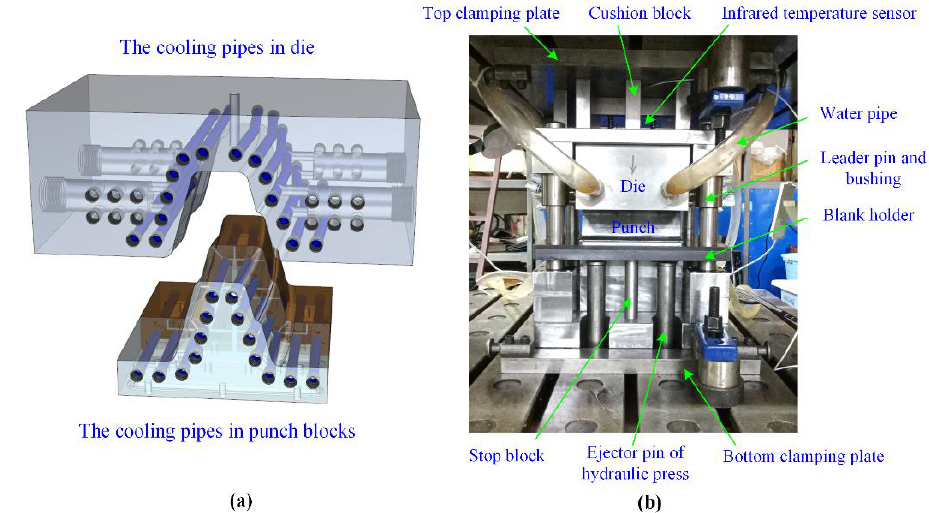
Figure 3. The hot stamping die for similar U-shaped sample: ( a ) the distribution of cooling pipes; ( b ) the experiment die.